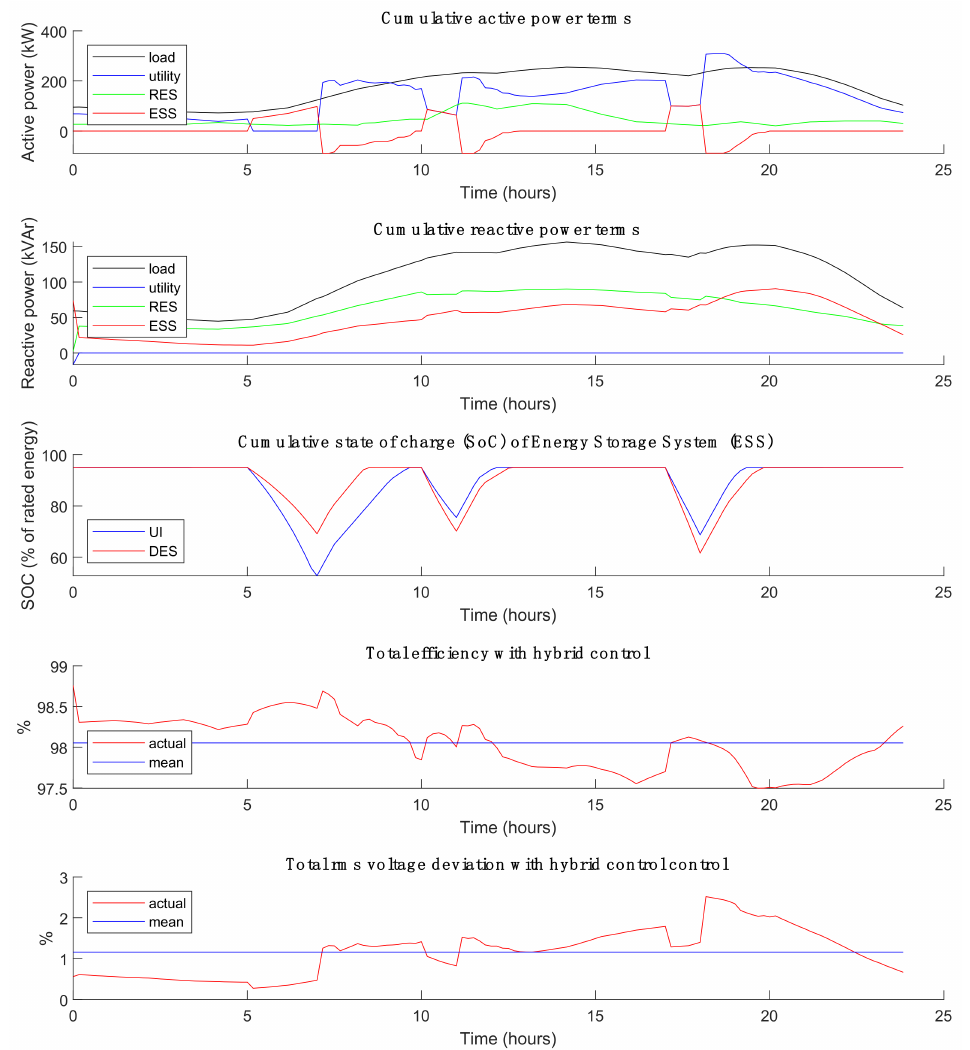
Figure 7. Results obtained with hybrid